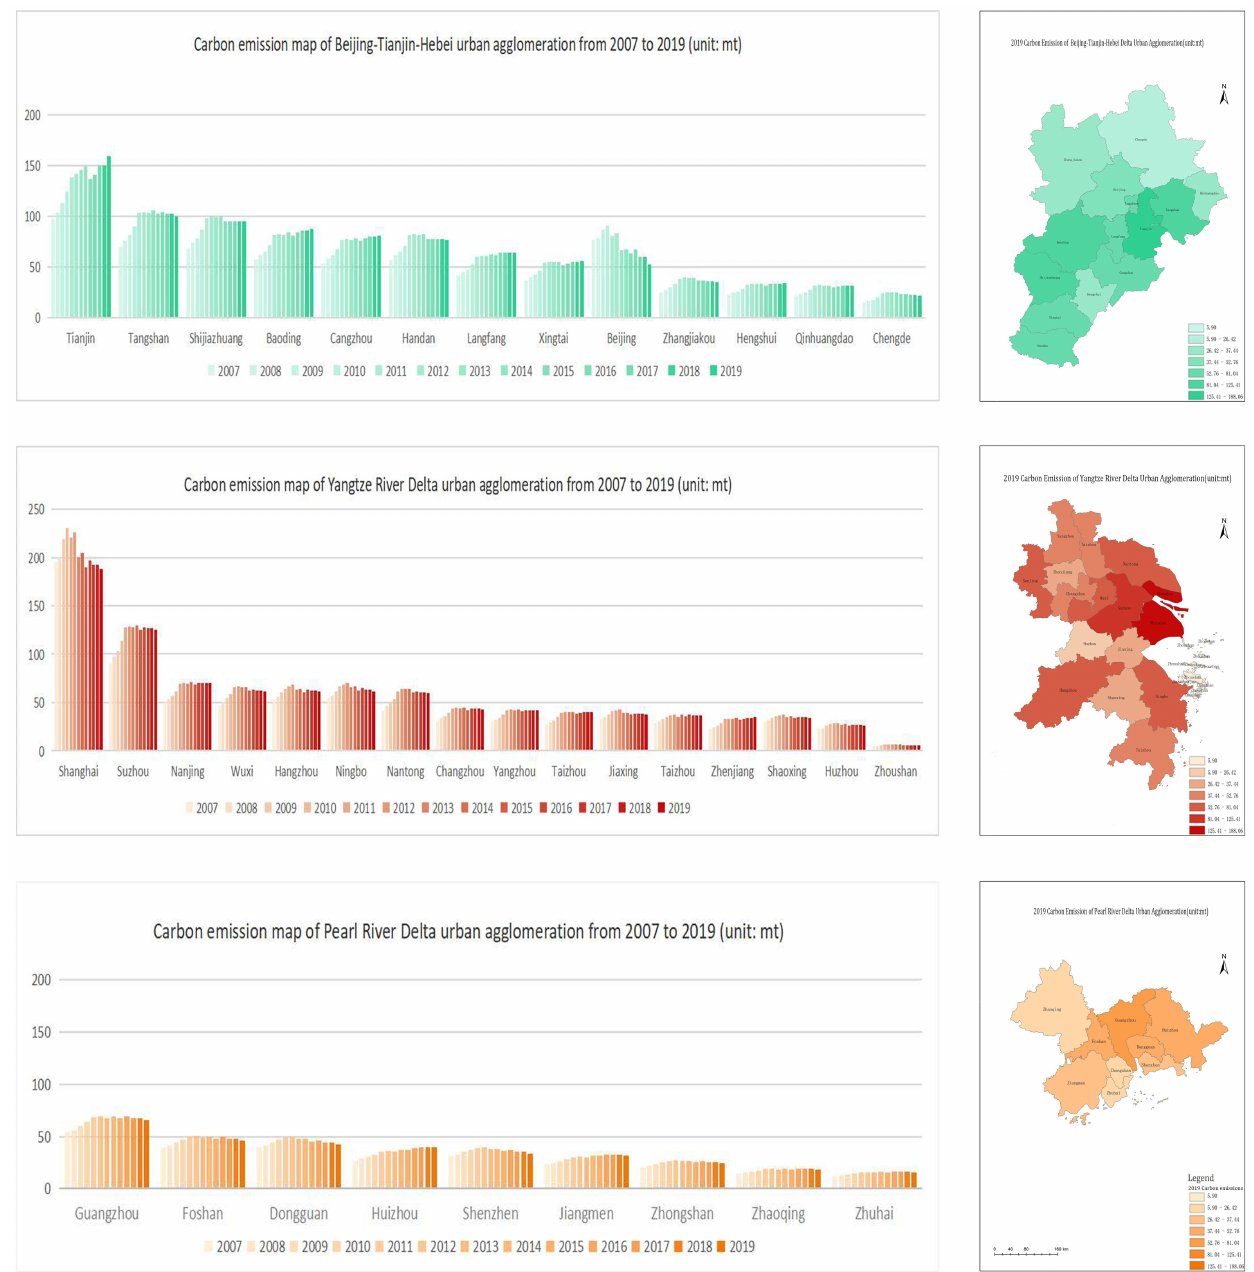
Figure 2. The carbon emissions of the three major UAs from 2007 to